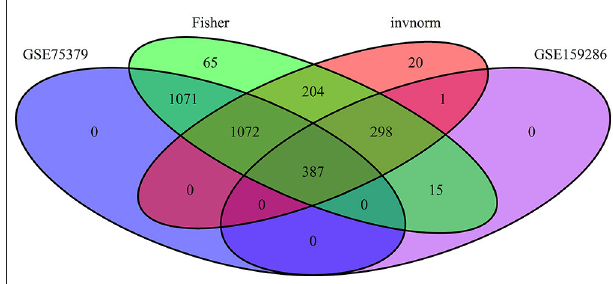
FIGURE 3 | Results of meta-analysis of RNA-seq data using Fisher and invorm method.